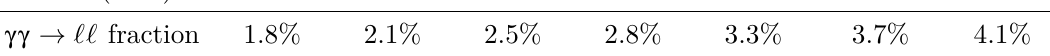
Table 5 . The fraction of photon-induced background as compared with the total amount of DY signal plus photon-induced events ( N are averaged across the different years and